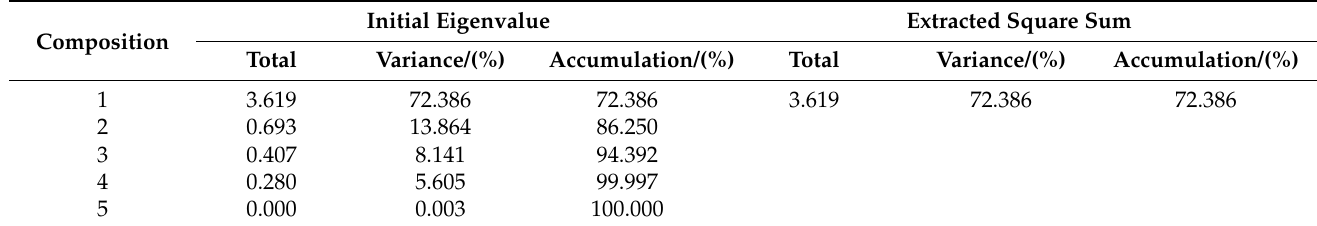
Table 5. Variance and variance cumulative contribution rate of each composition.